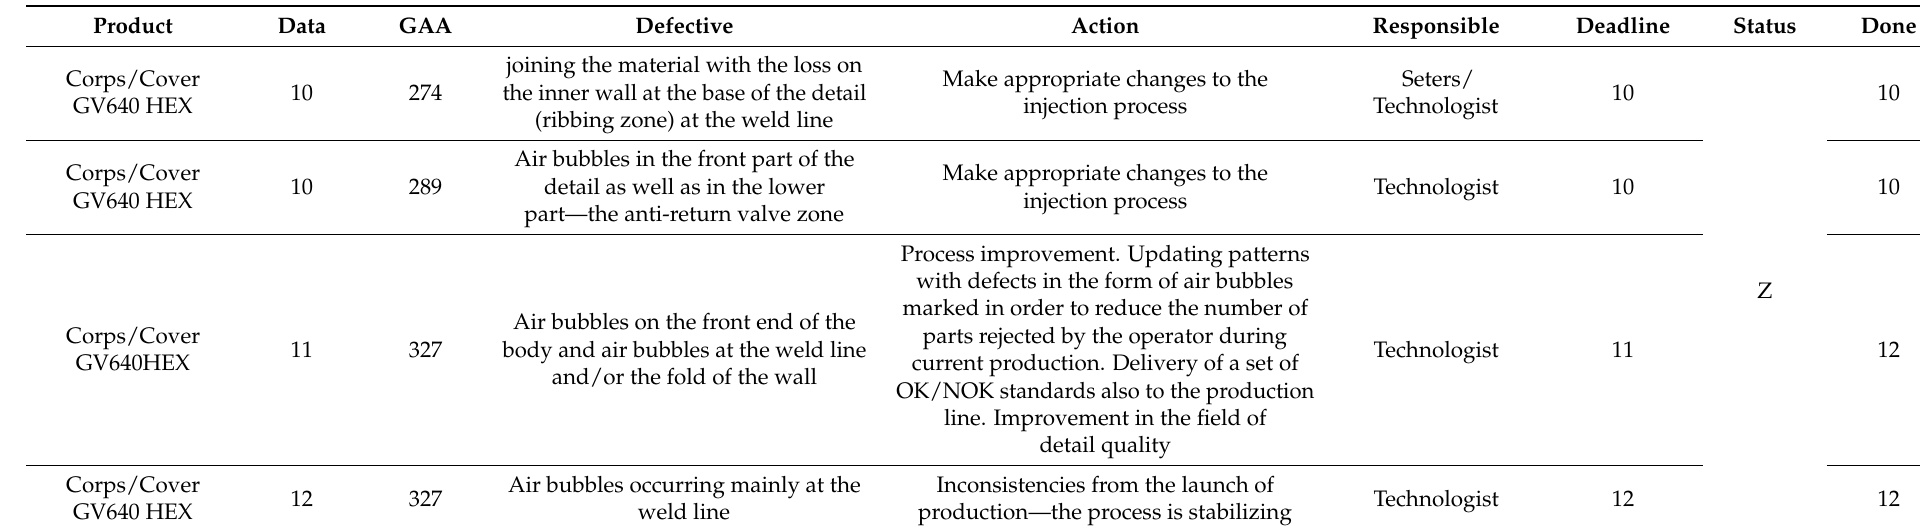
Table 4. GAA analysis—stocks in closed status.